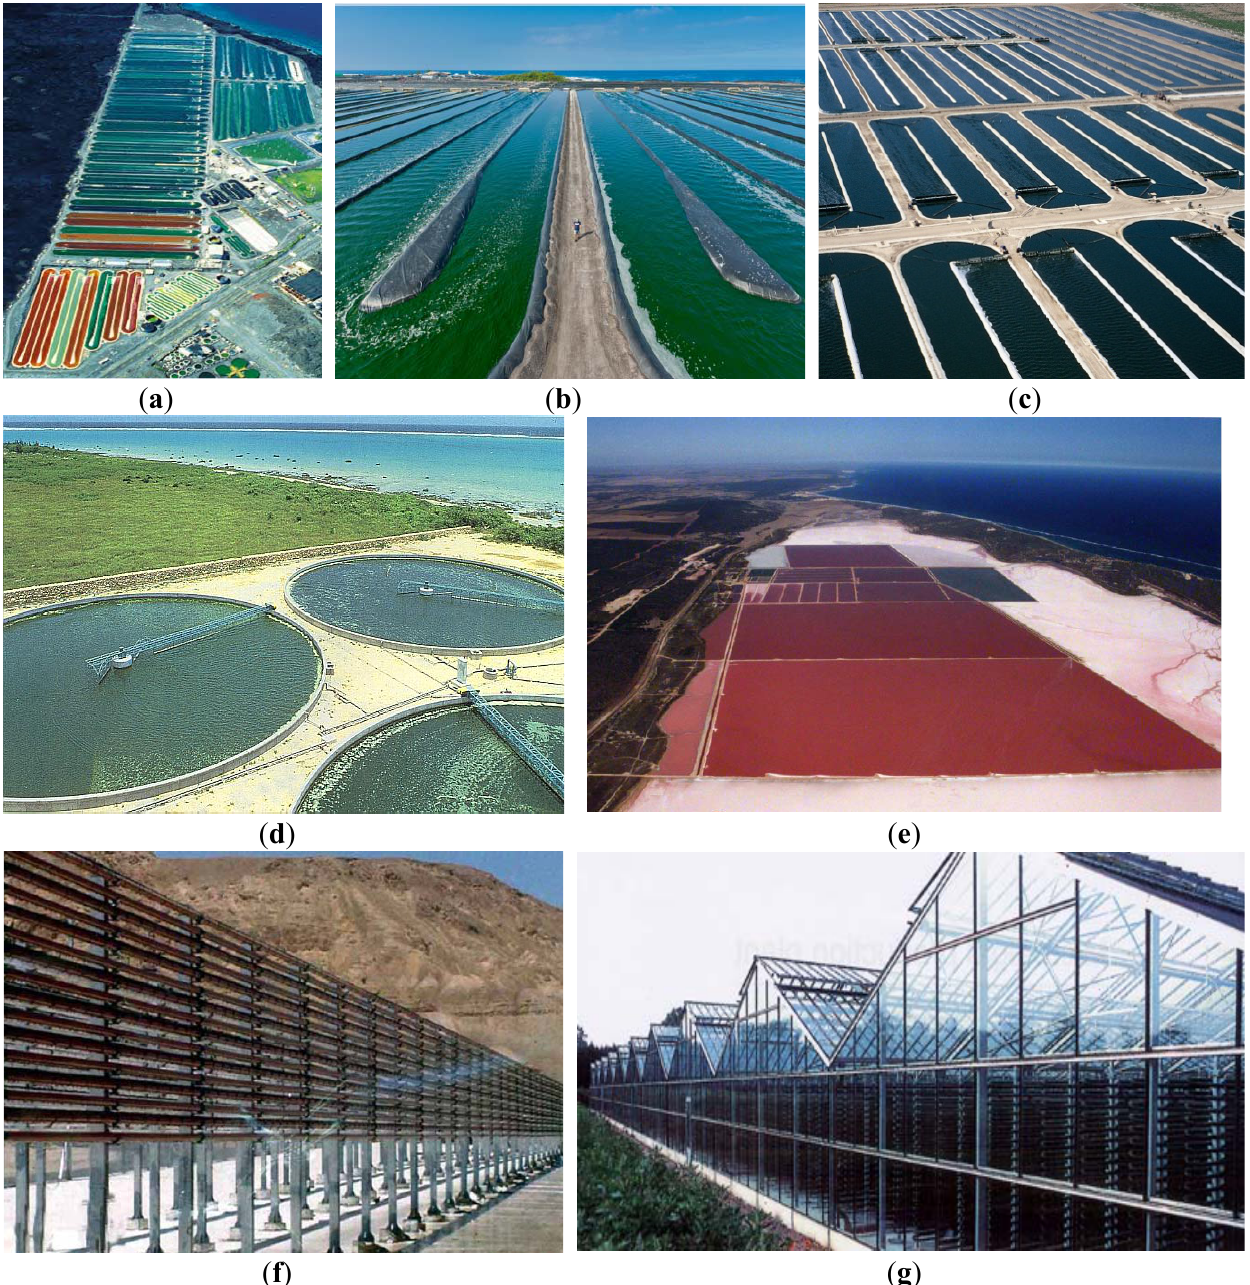
Figure 1. Commercial microalgae production systems: ponds and